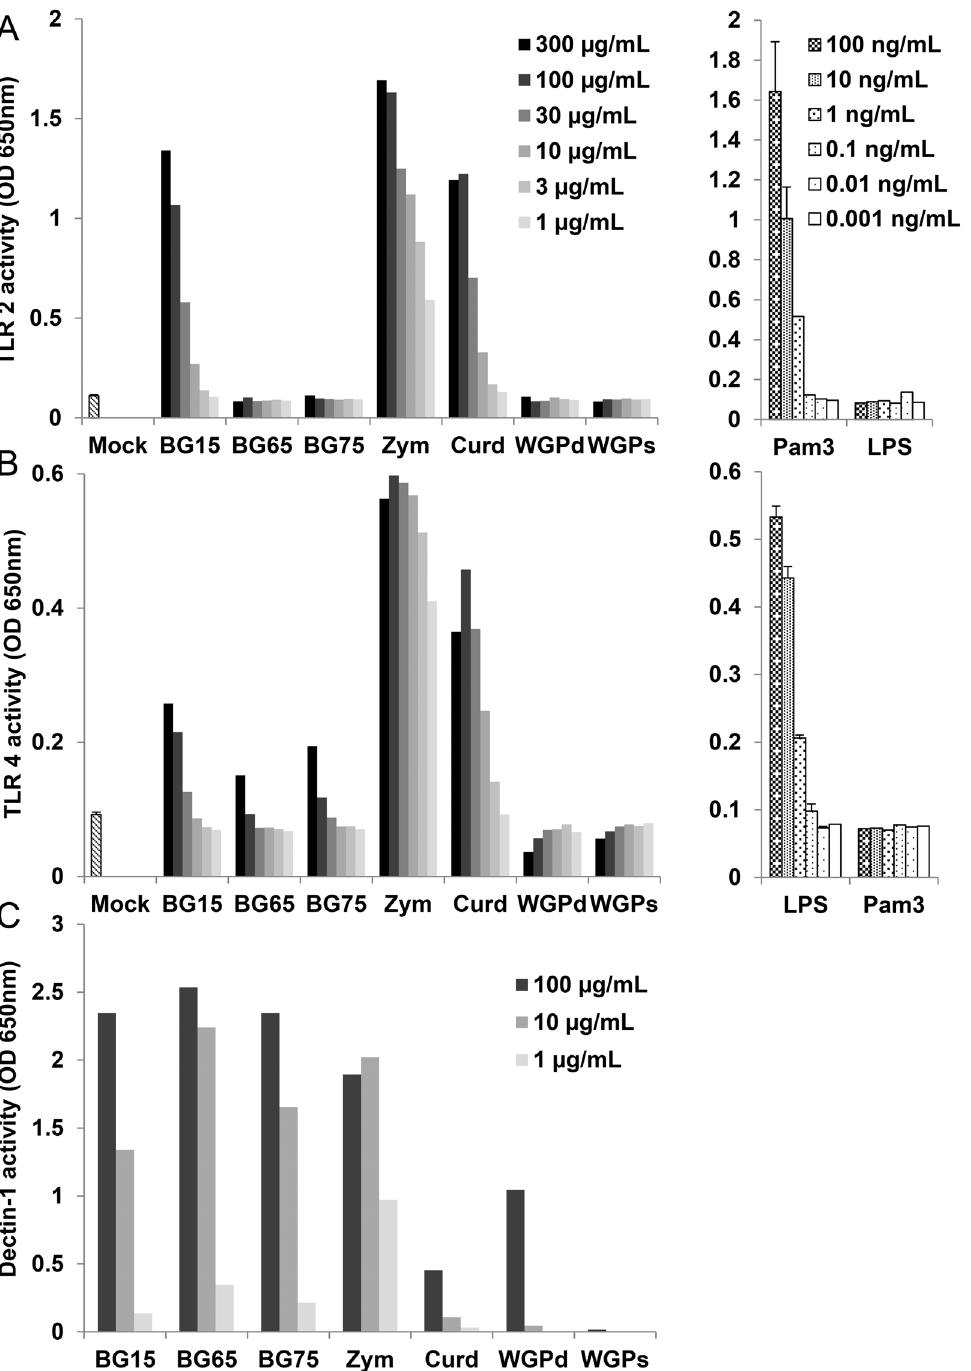
Fig 2. Enrichment of BG from yeast cell wall extracts strongly abolishes TLR2/4-related NF κ B/AP-1 activities conversely to dectin-1. (A-C) HEK-Blue ™ -hTLR2, -hTLR4 and hDectin-1 cells were incubated with serially diluted Sc BG cell wall extracts (BG15, BG65 and BG75) or their BG controls (zymosan, curdlan, dispersible and soluble WGP) for 16 h in culture medium containing the reporter reagent (37°C, 5% CO 2) . Each cell line was stimulated with a 10-fold serial dilution (from 100 ng/mL to 0.001 ng/mL) of control ligand, Pam3CSK4 for HEK-Blue ™ -hTLR2 and ultraPure LPS for HEK-Blue ™ - hTLR4, respectively as shown in the panels on the right of A and B. The NF κ B/AP-1-related activity of TLR2, TLR4 and dectin-1 was assessed in supernatants by a colorimetric assay. The OD value of a blank control, which corresponds to the OD value of HEK-Blue detection medium, was subtracted from the OD values of samples. The results are presented as OD 650 nm values and are representative of three independent experiments.